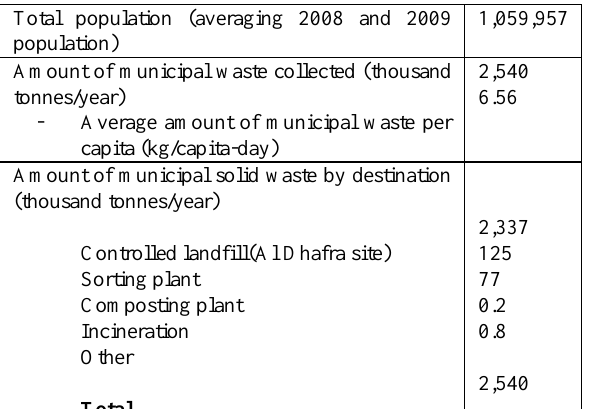
Table 1. Summary of waste situation in Abu Dhabi region